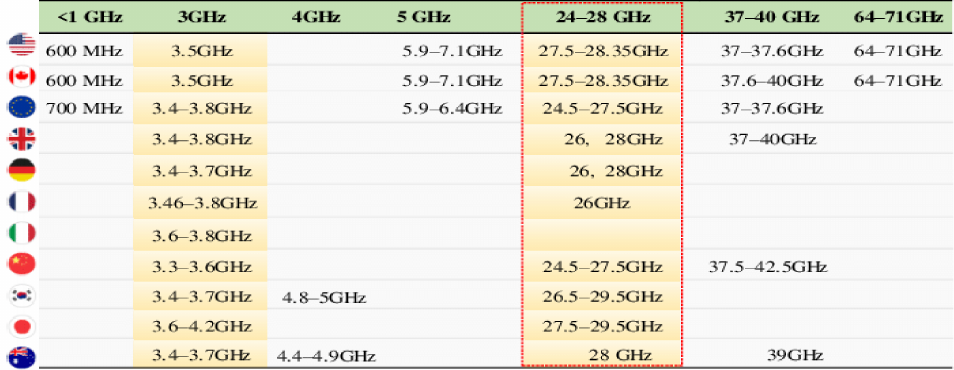
Figure 1. Snapshot of global frequency spectrum. More than 1.1 million assigned frequencies are contained in this database. In addition, about 350,000 assigned frequencies for the broadcasting-satellite service and 25,000 allotted frequencies for the fixed-satellite service are planned for future